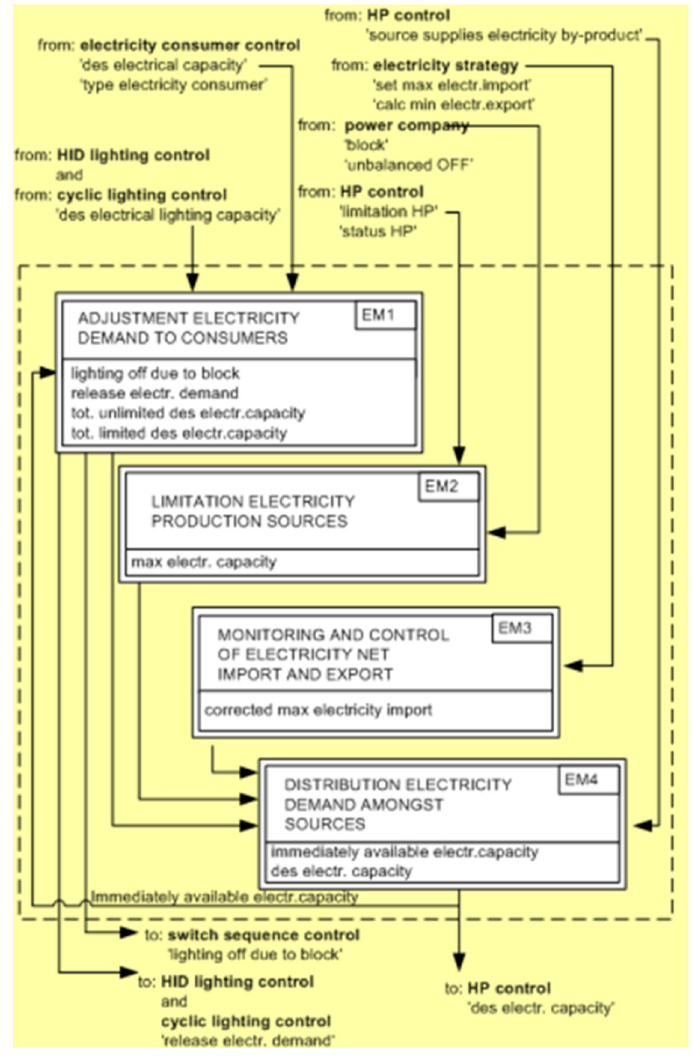
Figure A3. Structure of electricity management.